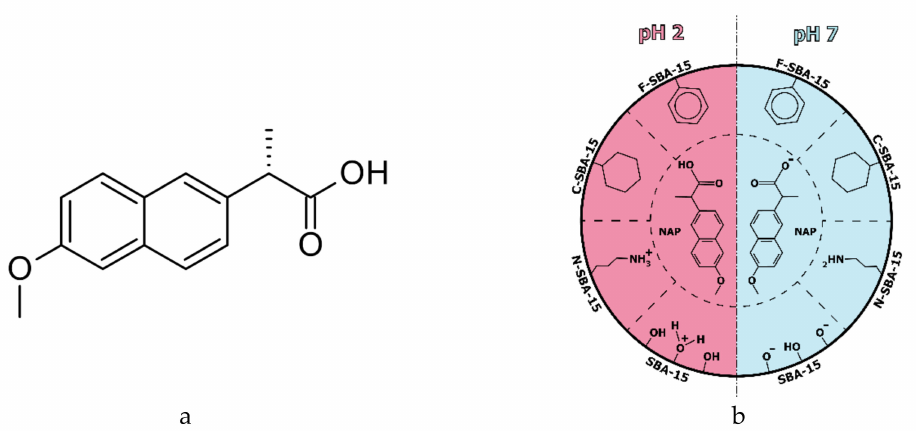
Figure 1. ( a ) Molecular structure of naproxen (NAP), ( b ) Schematic representation of interaction of NAP with di ff erent surface modified MPS (for the abbreviations, see the paragraph in Section 2